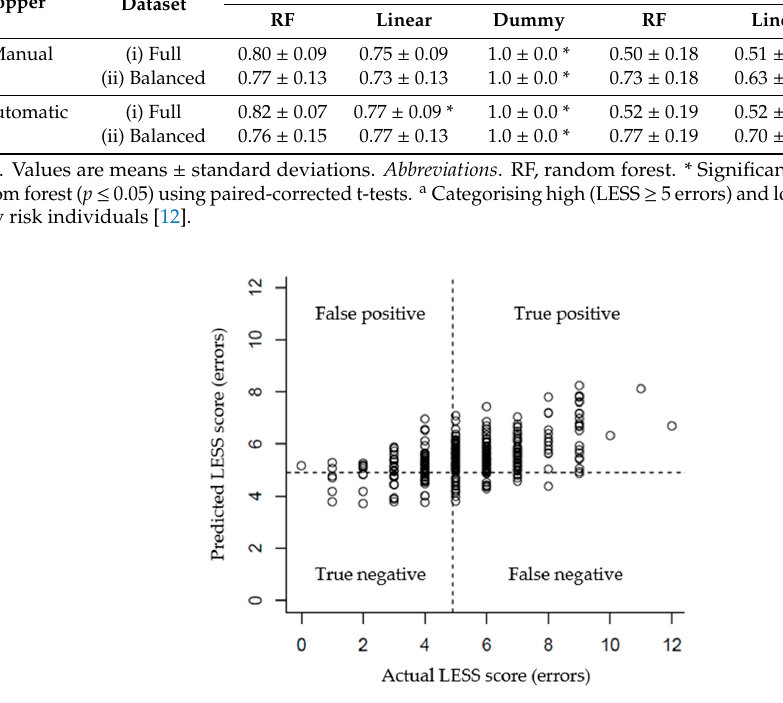
Figure 4. Actual (clinical) versus predicted (automated) LESS score plots from the random forest regression using full dataset (n = 320) and automatic cropping method. Dashed lines represent the 5 ‐ error threshold that defines high risk of injury (i.e., scoring 5 or more errors during LESS has been associated with a 10.7 times greater relative risk of sustaining a non ‐ contact anterior cruciate ligament injury [12]). Note that the clinical scores are integers and predicted scores are decimals, which adds granularity. Abbreviations : LESS, Landing Error Scoring System.